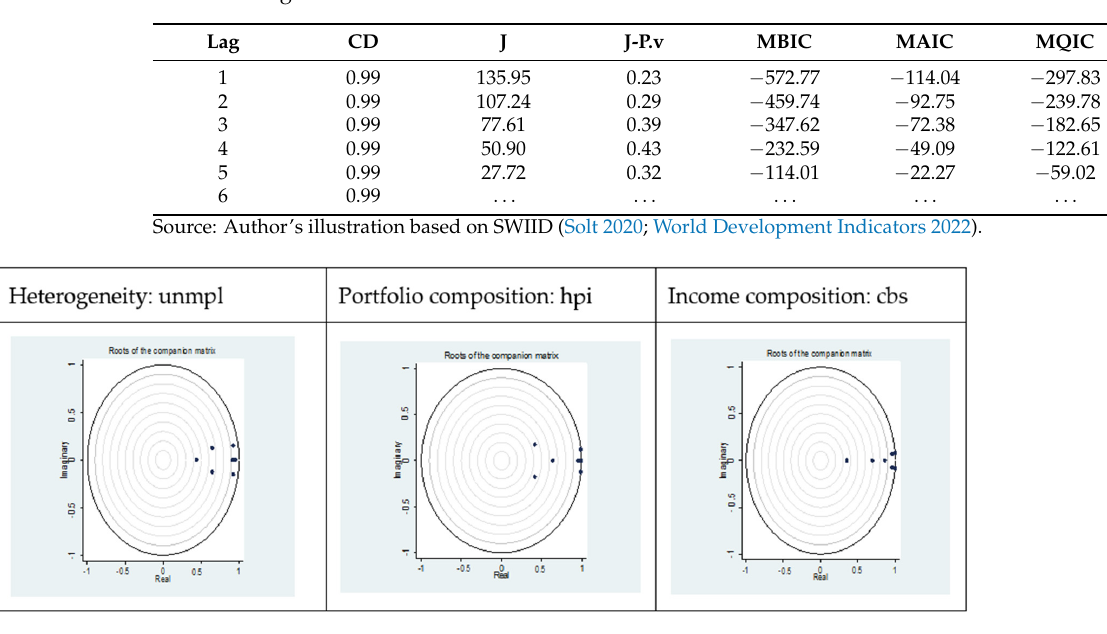
Figure A1. Eigenvalue stability condition when PTI10% is used to measure income inequality. Note: All the eigenvalues lie inside the unit circle. PVAR satisfies stability condition. Source: Author’s illustration based on SWIID (Solt 2020; World Development Indicators 2022).